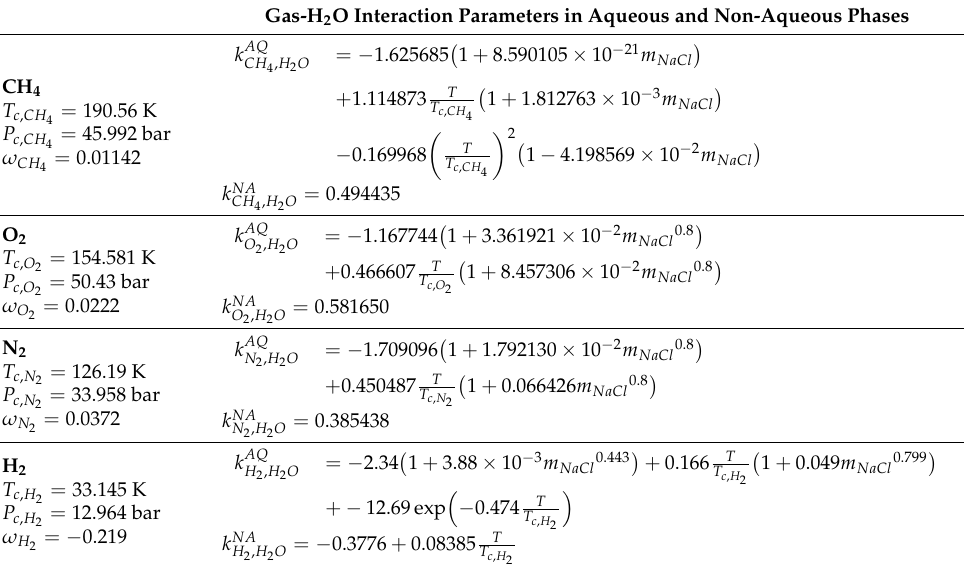
Table 3. Gas-H 2 O interaction parameters in aqueous and non-aqueous phases for the SW EoS. Gas-H 2 O Interaction Parameters in Aqueous and Non-Aqueous Phases